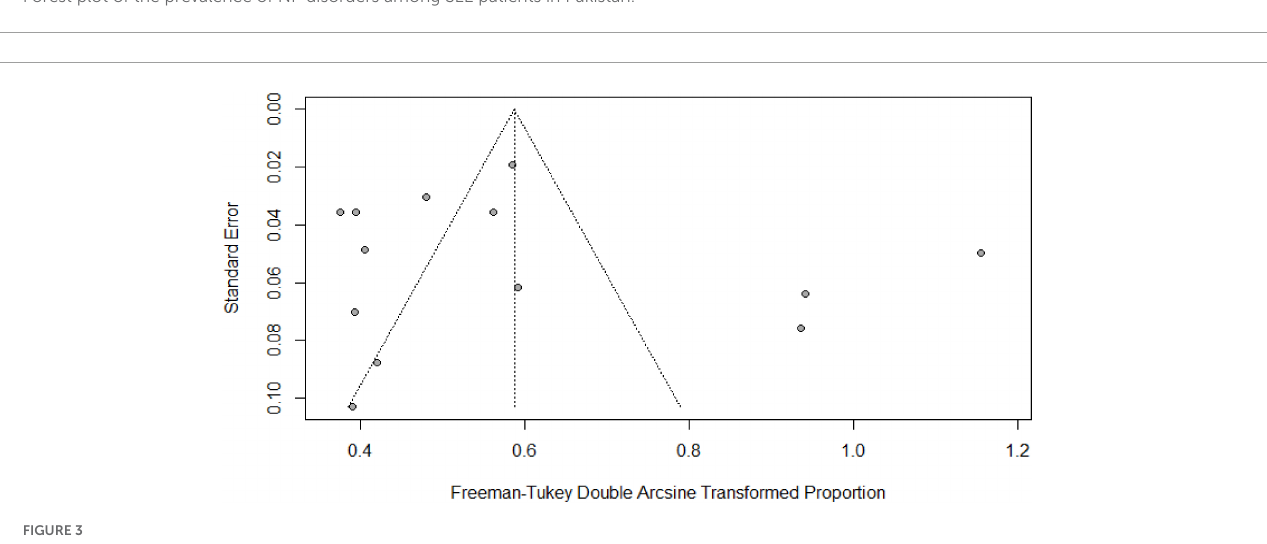
FIGURE2 Forest plot of the prevalence of NP disorders among SLE patients in Pakistan.